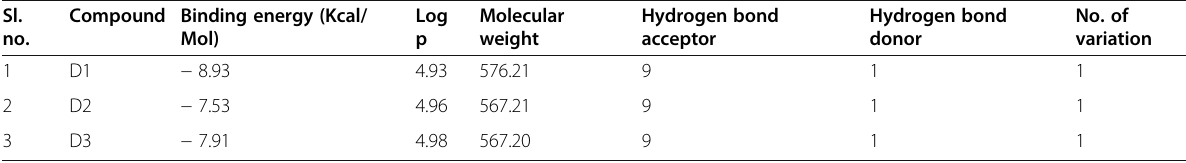
Table 2 Docking score and molecular properties of the designed compound Sl. no.